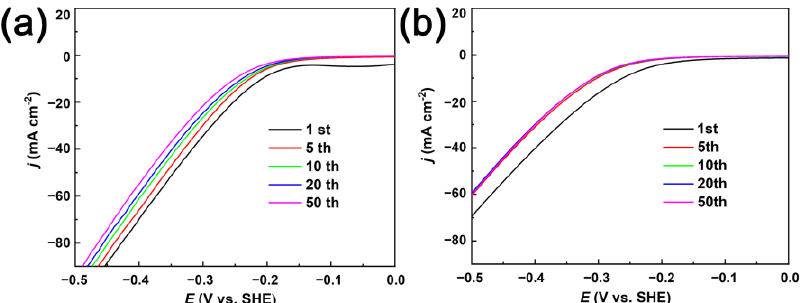
Figure 10. LSV curves of porous ( a ) and fully dense ( b ) CuNi films in N 2 -saturated 1 M KOH solution.